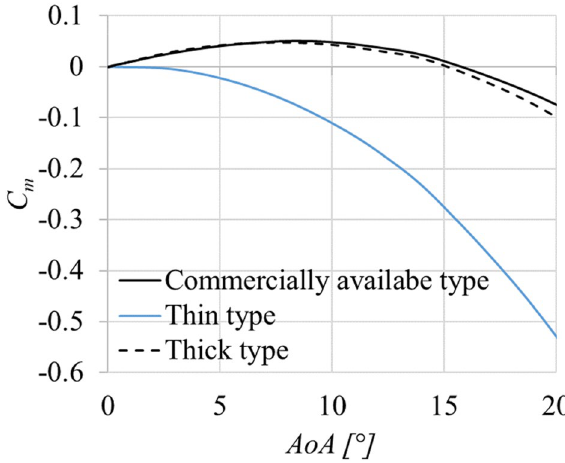
Figure 13. The pitching moment coefficient, C m , obtained by CFD for the three